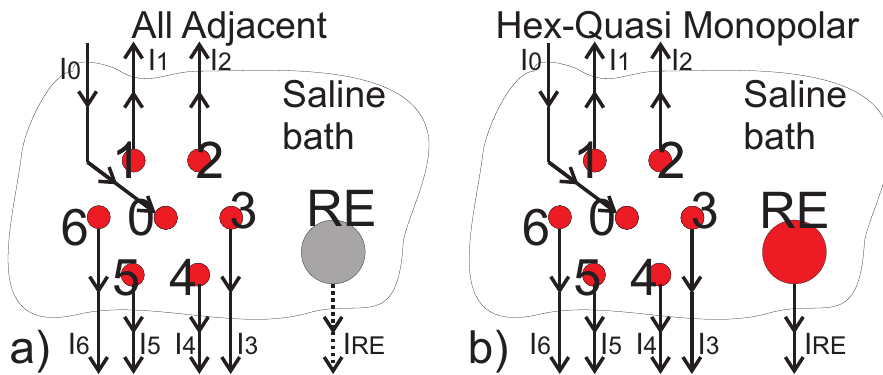
Figure 6. Sketch of ( a ) All Adjacent (AA) and ( b ) Hex Quasi-monopolar (HQ) return stimulation patterns with the respective current pulses’ directions and the return electrode